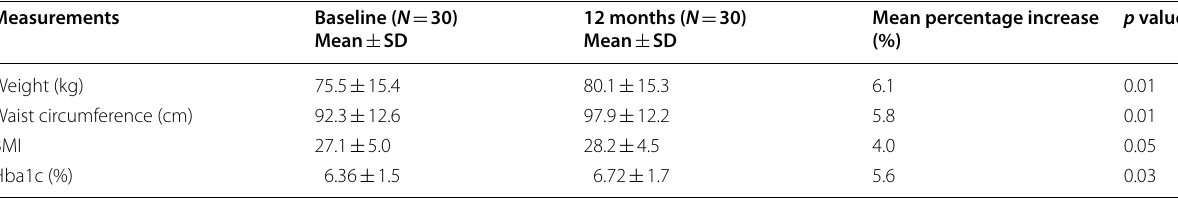
Table 4 Anthropometric variables for prostate cancer cases